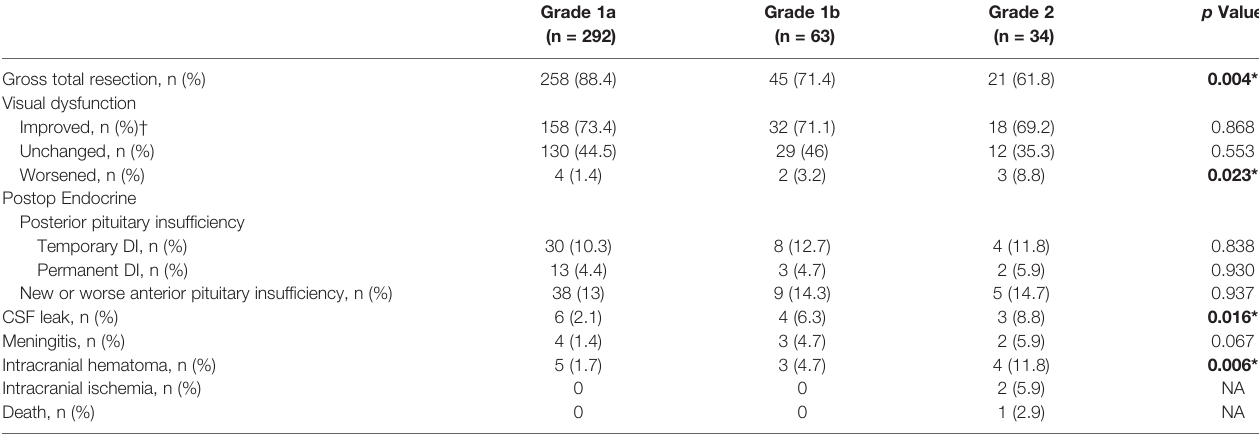
TABLE 2 | Clinical outcomes in patients with suprasellar pituitary